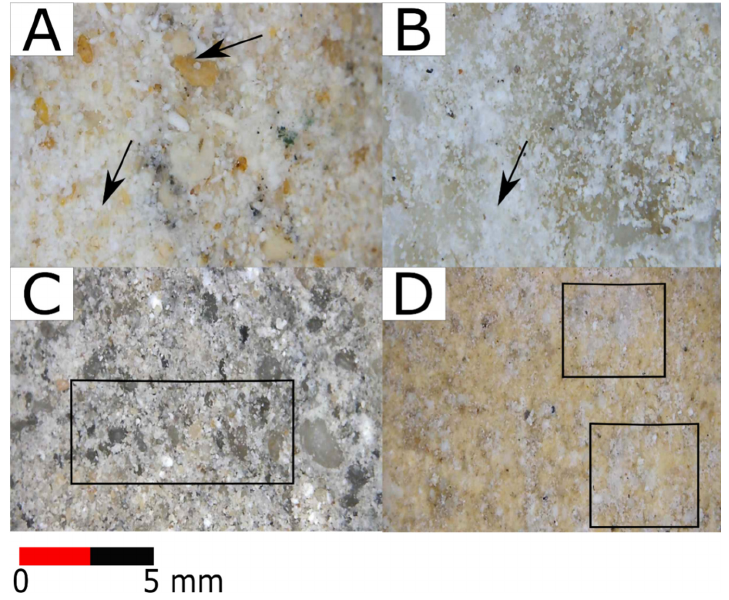
Figure 17. ( A – D ) Photomicrographs under a binocular microscope for the bedrock (BR), casting stone (CS), coarse-grained rendering mortar (CRM), and fine-grained rendering mortar (FRM). Black arrows and rectangles show the ooids, quartz grains, disintegration, and salt crusts on different samples. Apparently, salt erosion is the main feature of deterioration for all samples.